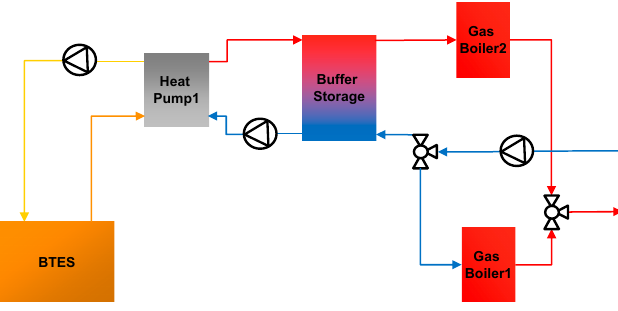
Figure 4. System layout of serial heating scenarios.